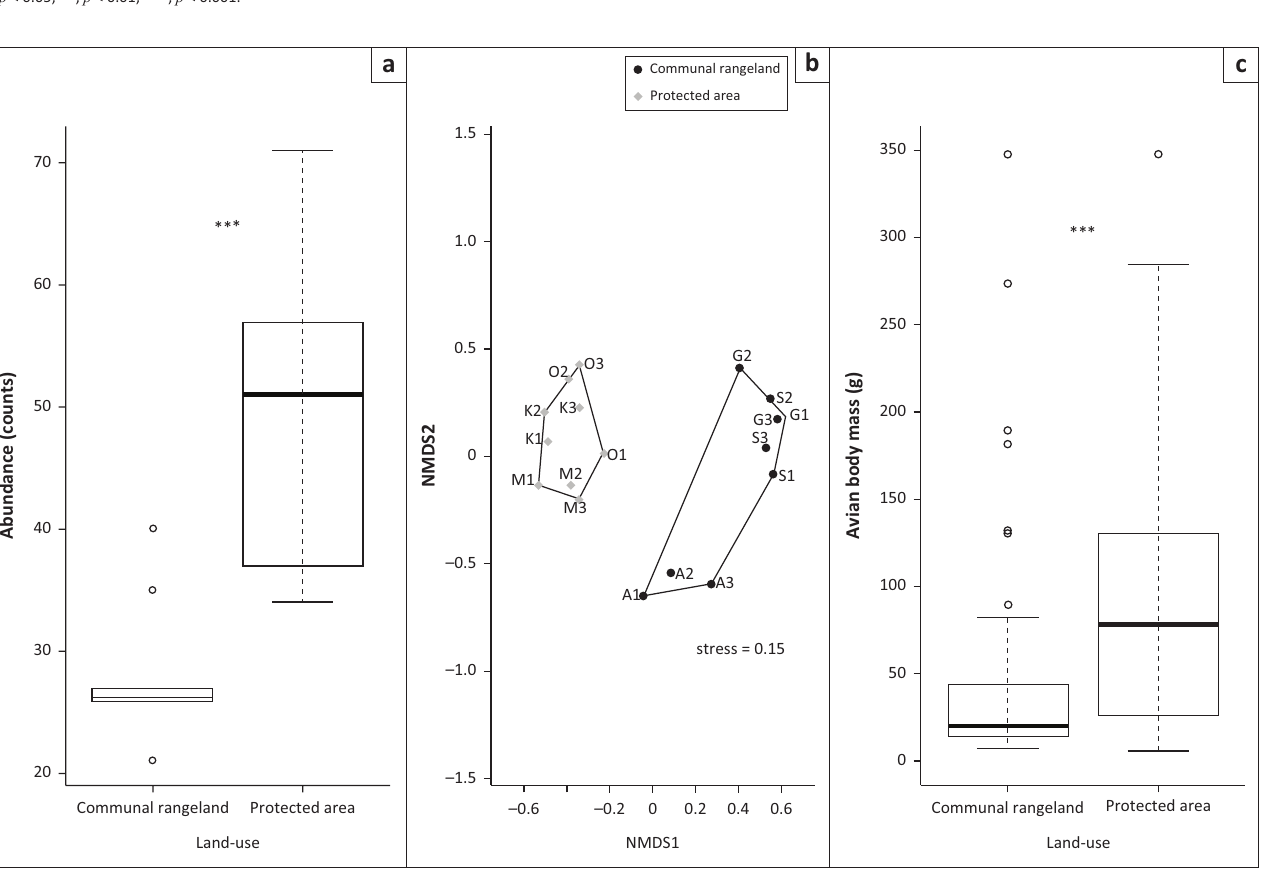
Land-use × maximum grass